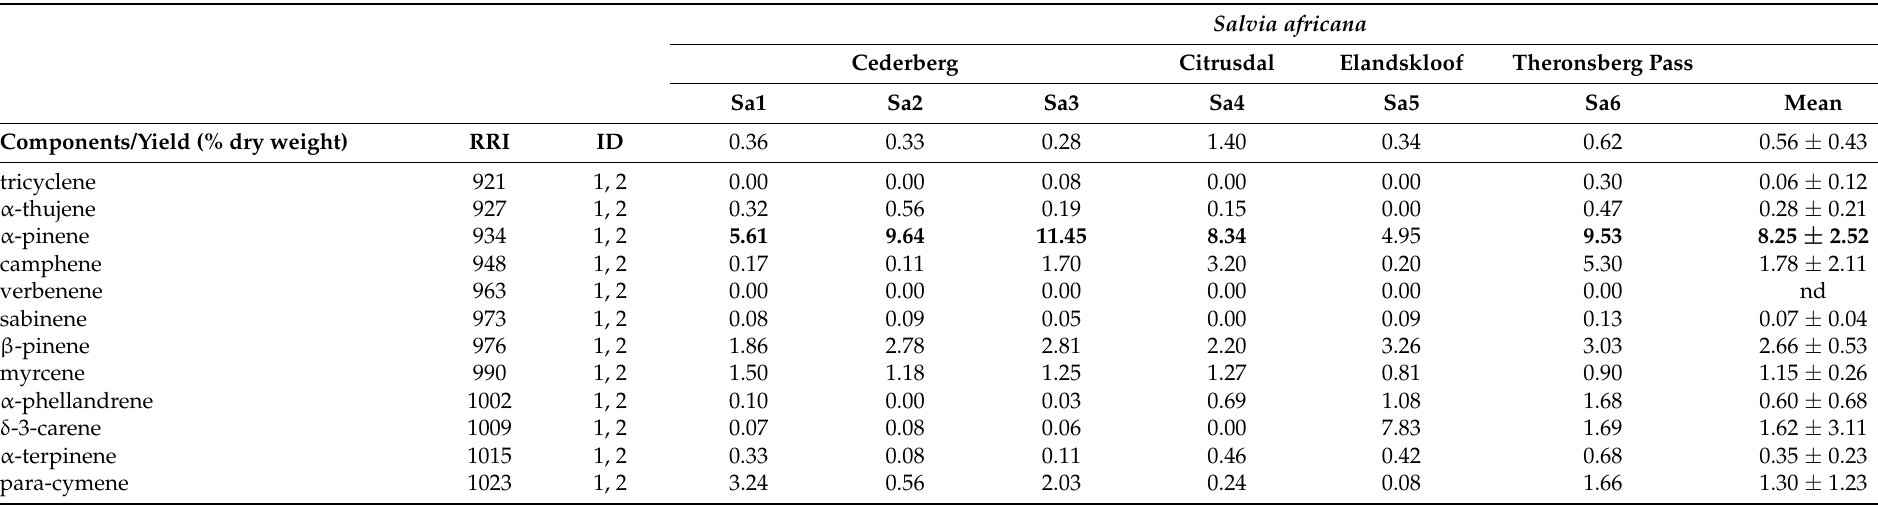
Table 3. Identified essential oil components (%) of Salvia africana